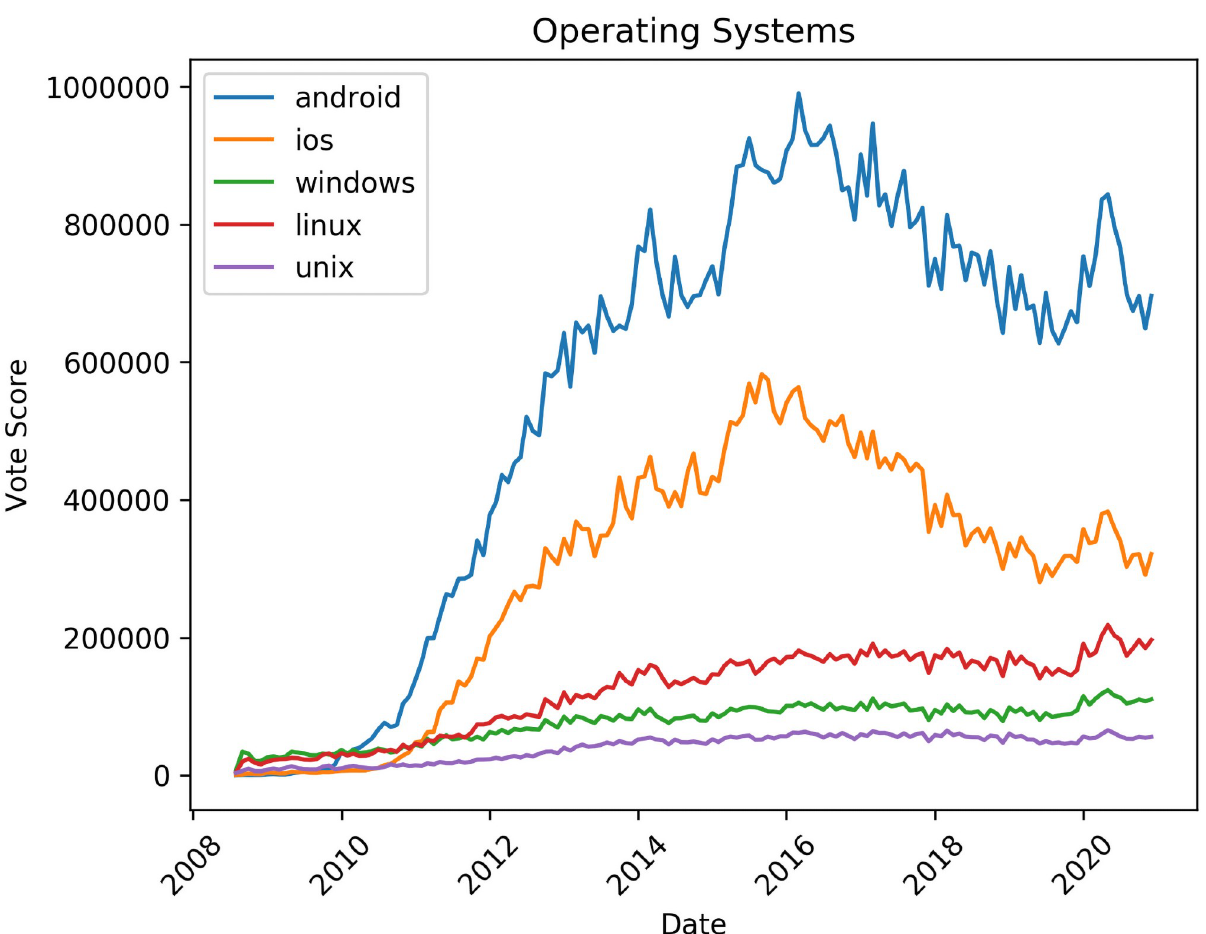
Fig 4. Trends in tag popularity: Operating